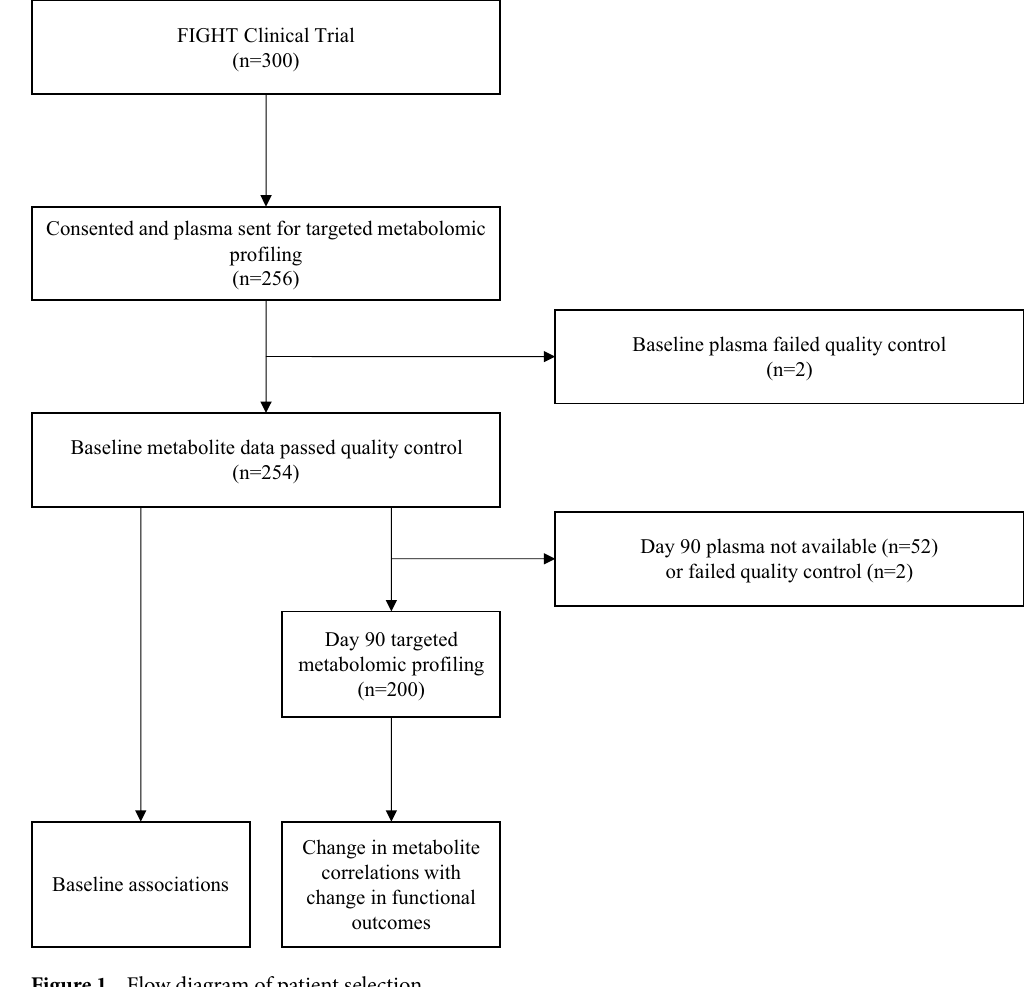
Figure 1. Flow diagram of patient